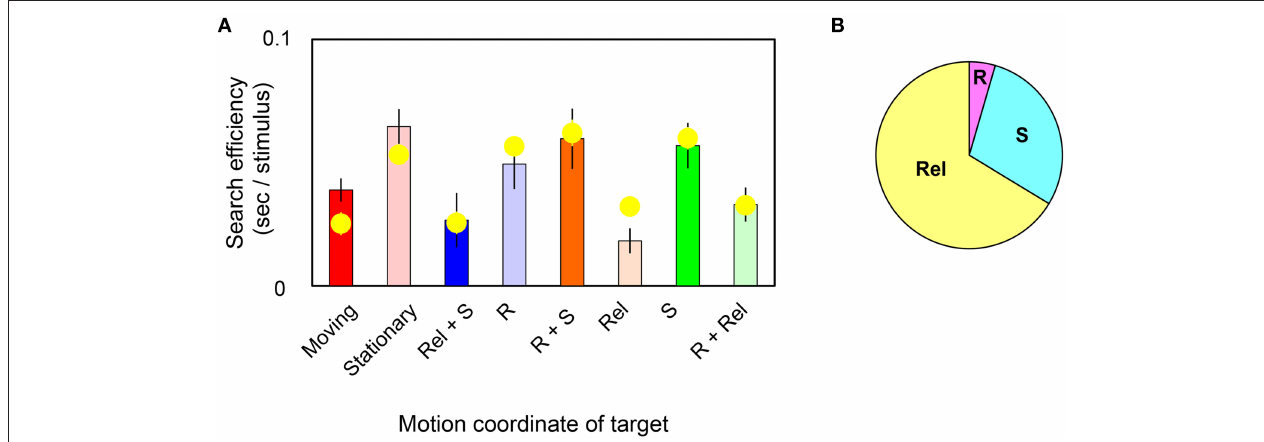
FIGURE 4 | (A) Each bar shows the slope value of the MOVING/STATIONARY target for four different motion conditions in target-present trials. Yellow circles represent the average of the slope value as estimated by the weighted-sum model. Error bars represent weights of retinal (R), relative (Rel), and spatiotopic (S) motions as estimated by the weighted-sum model.